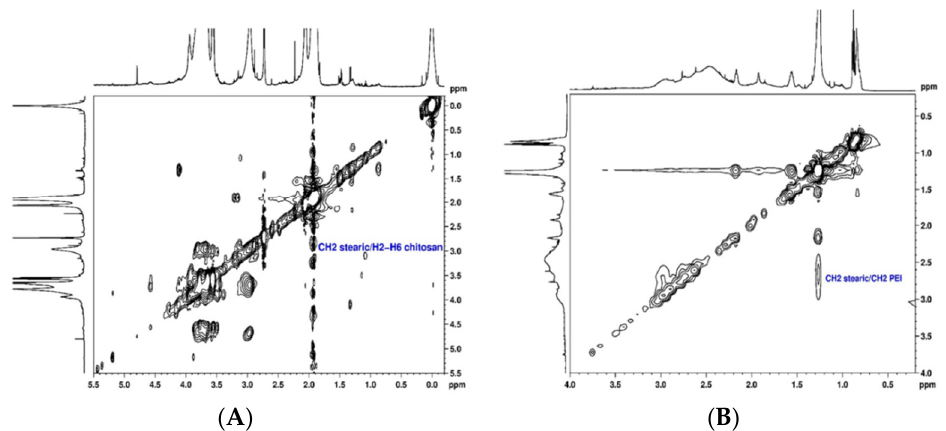
Figure 1. Structural characterization of the chitosan–stearic acid (CS-SA) and polyethyleneimine–stearic acid (PEI-SA) conjugates: ( A ) 1 H, 1 H-TOCSY spectrum of stearic acid bound to chitosan in D 2 O; ( B ) 1 H, 1 H-NOESY spectrum of stearic acid bound to polyethyleneimine in CDCl 3 .